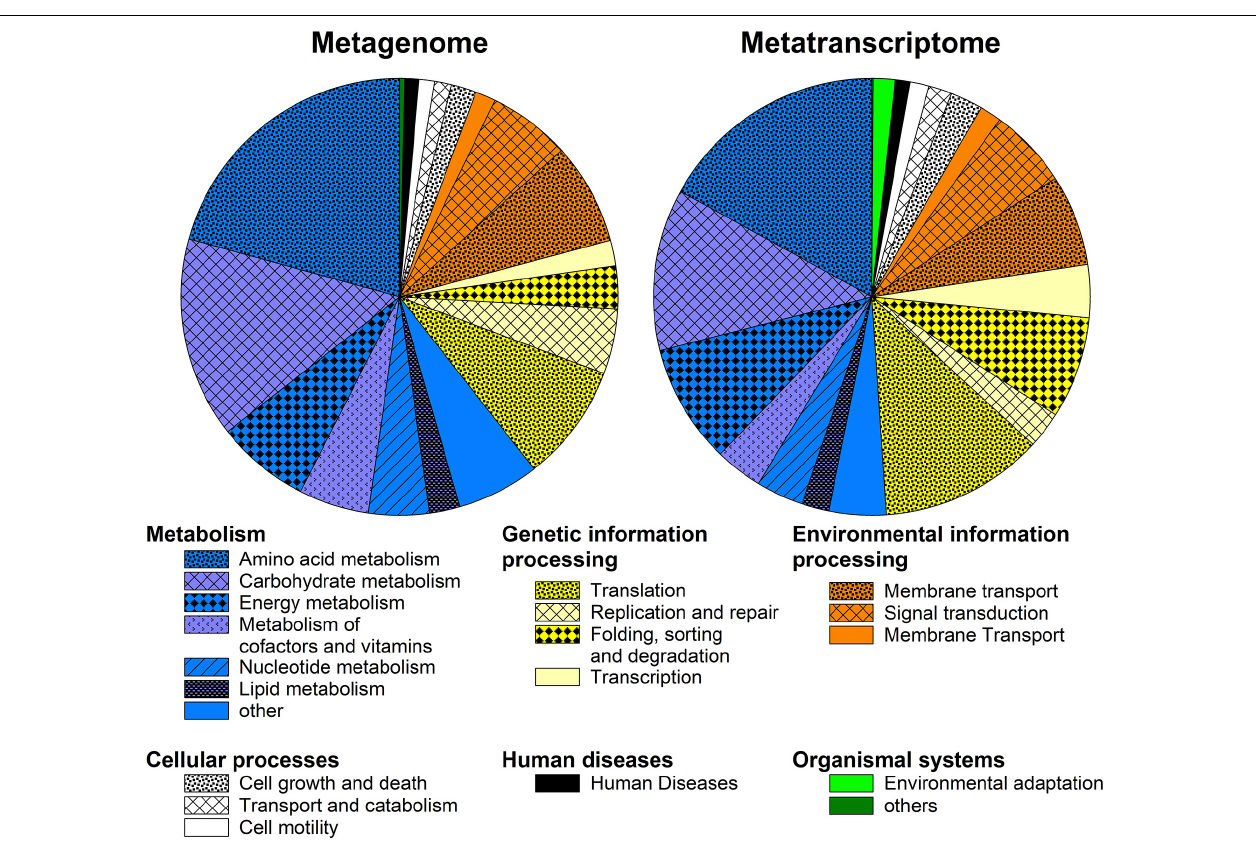
FIGURE 2 | Functional profiles in the peat metagenome and metatranscriptome based on KEGG Orthology annotations in MG-Rast. The most abundant level 2 pathways are displayed.